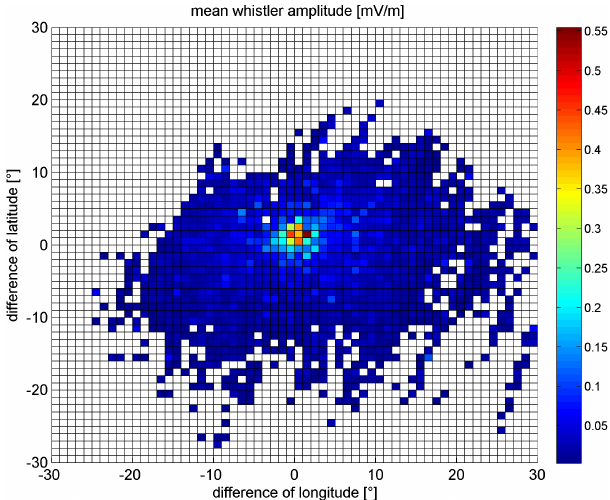
Fig. 7. Mean whistler amplitude as a function of lightning current and distance between the reference point and locations of lightning for daytime